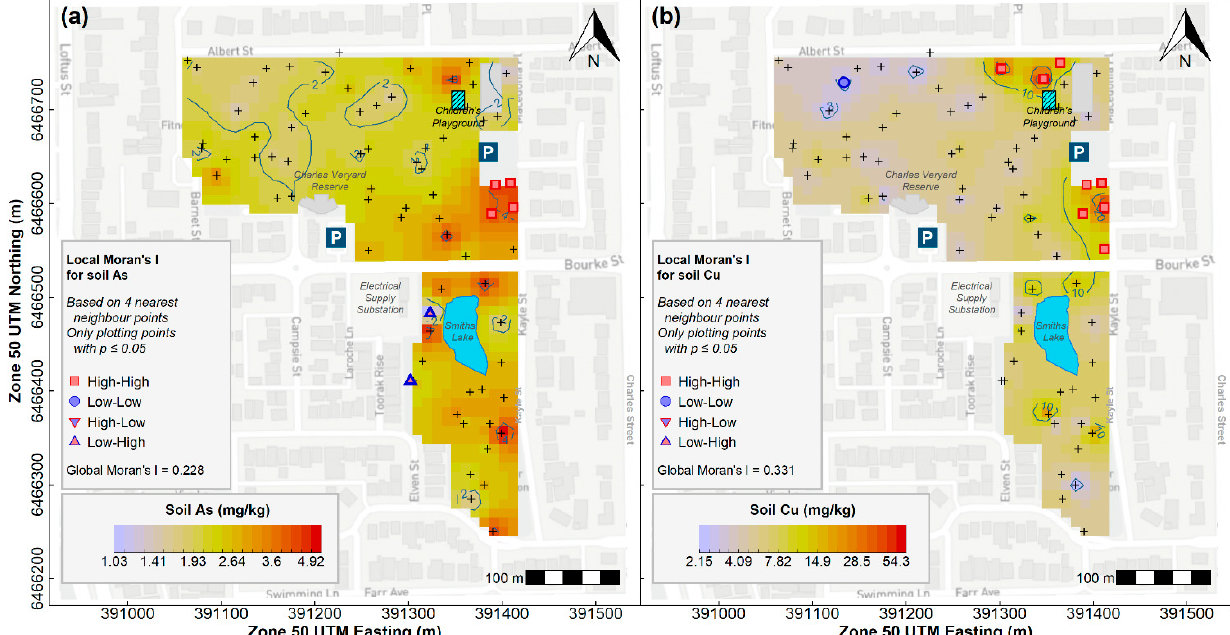
Figure 3. Spatial distributions of ( a ) As and ( b ) Cu in soil across Smith’s Lake and Charles Veryard Reserves, interpolated by inverse distance weighting with significant local spatial autocorrelations (Local Moran’s I ≤ 0.05) indicated with filled symbols. All sample points shown by +